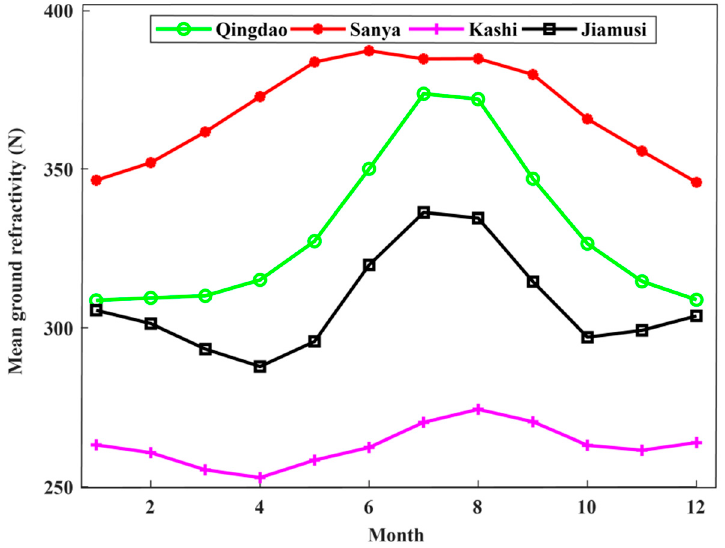
Figure 12. The mean ground refractivity in different months of 10 years’ radiosonde data.